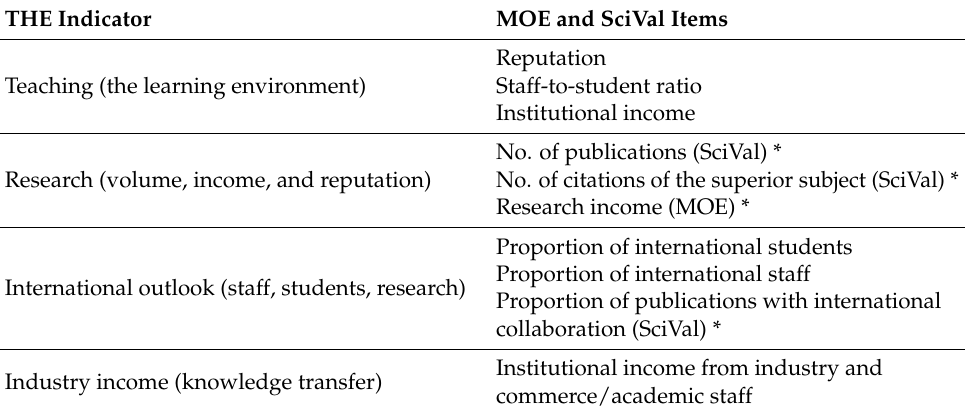
Table 1. MOE database, SciVal, and THE World University Ranking common indicators. THE